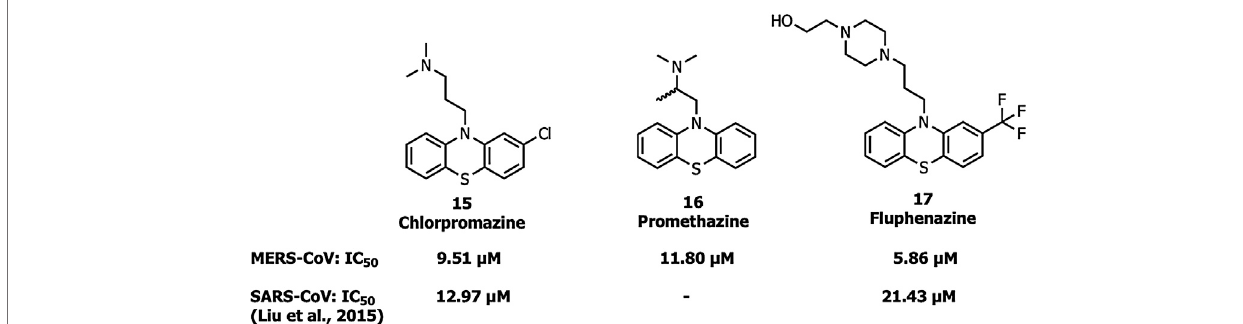
FIGURE 7 | Neurotransmitter inhibitors targeting clathrin/non-clathrin pathways.